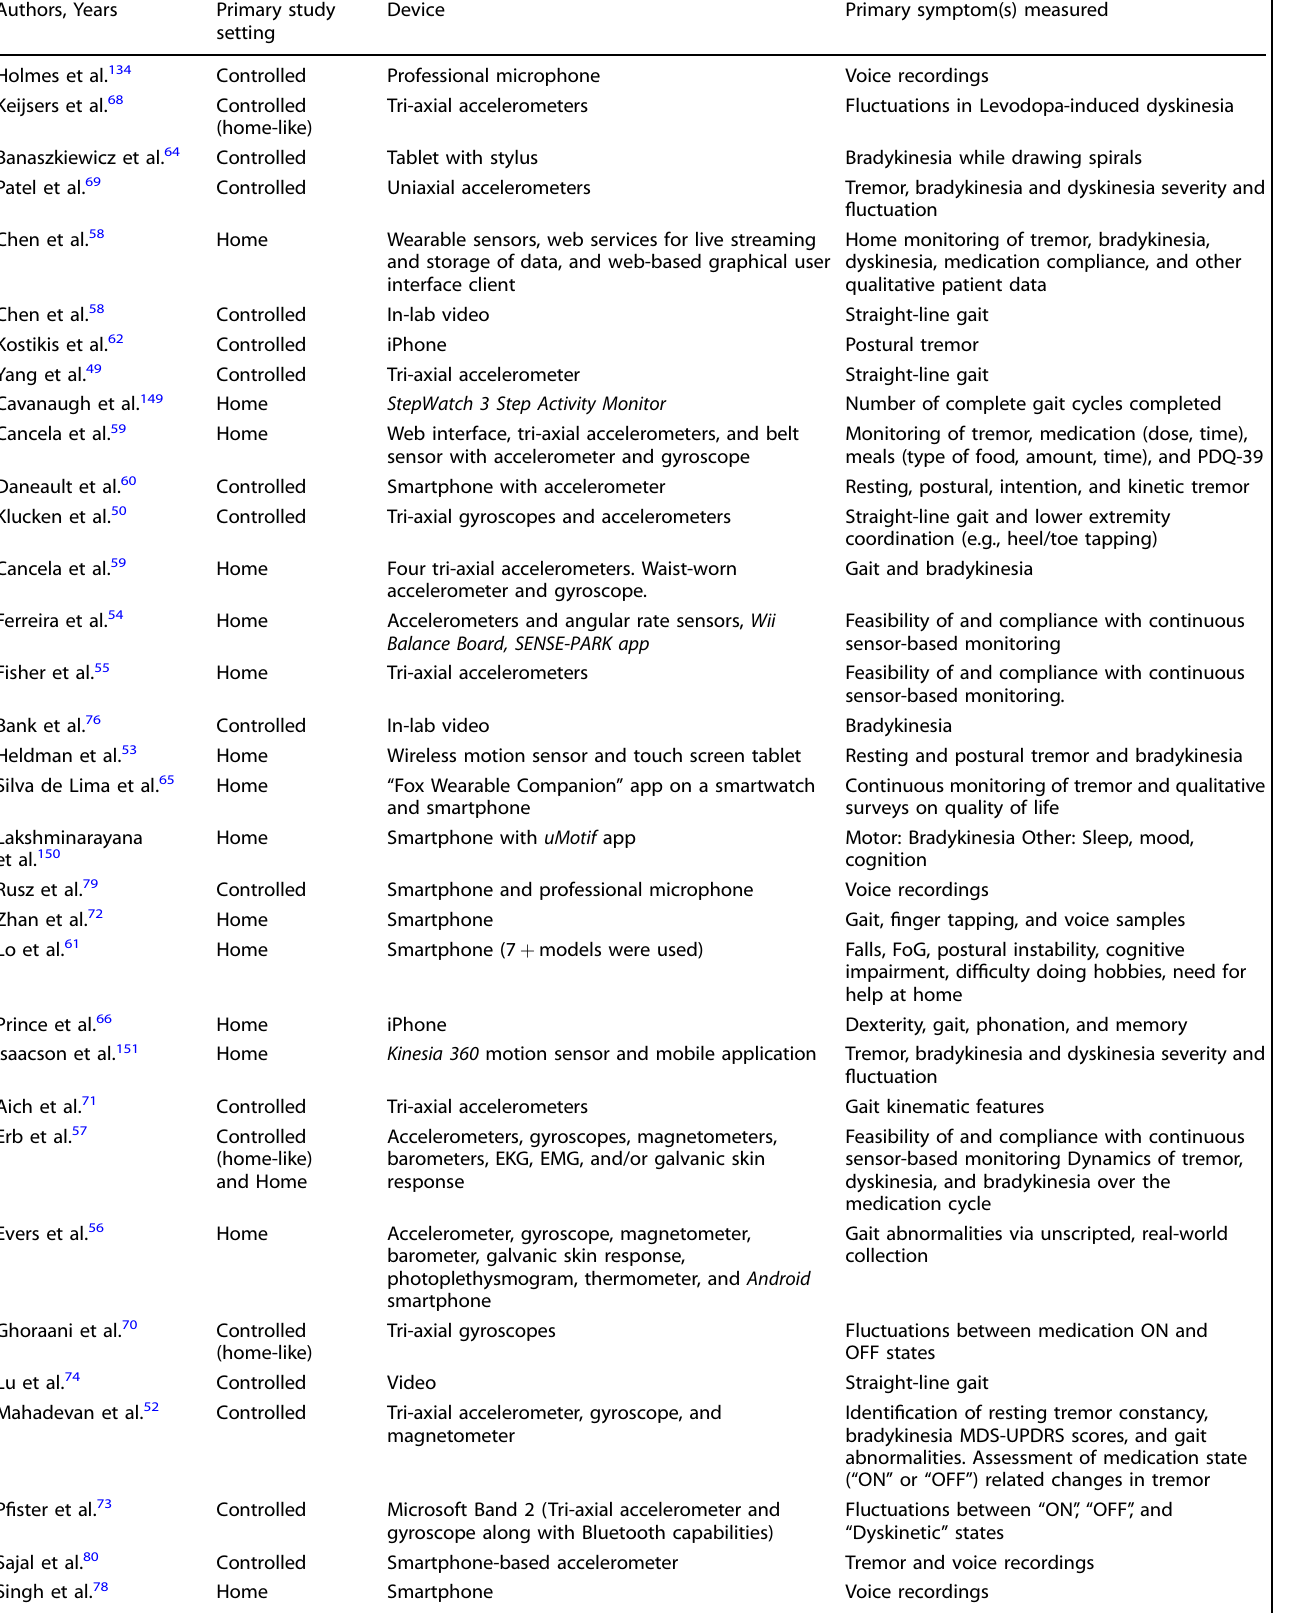
Table 2. Progression of technology used to monitor and assess PD symptoms in the home